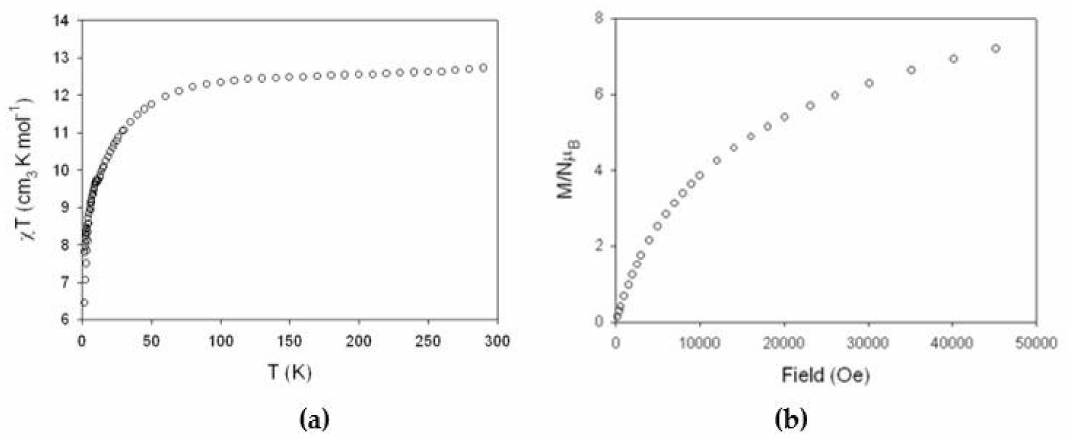
Figure 7. ( a ) χ T vs. T plot for SYML2-Mn measured with an applied dc field of 0.5 T. ( b ) Magnetization vs. field plot for SYML2-Mn at 2